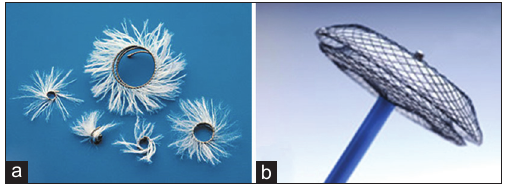
FIGURE 1. Gianturco coil (cylindrical shape) (A) and Amplatzer